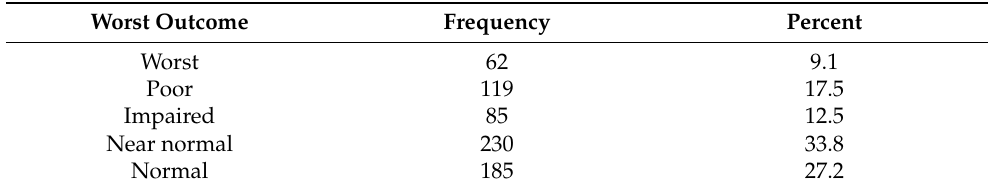
Table 6. Poorest outcome in at least one of six functional domains (food intake, breathing, speech, pain, mood, and neck and shoulder mobility) in 681 patients with incident HNC. A normal or near-normal outcome in all six functional domains was observed in 61% of HNC-patients; however, 30% had a relevant impairment in at least one functional domain and 9.1% had maximal functional impairment (worst possible outcome) in at least one functional